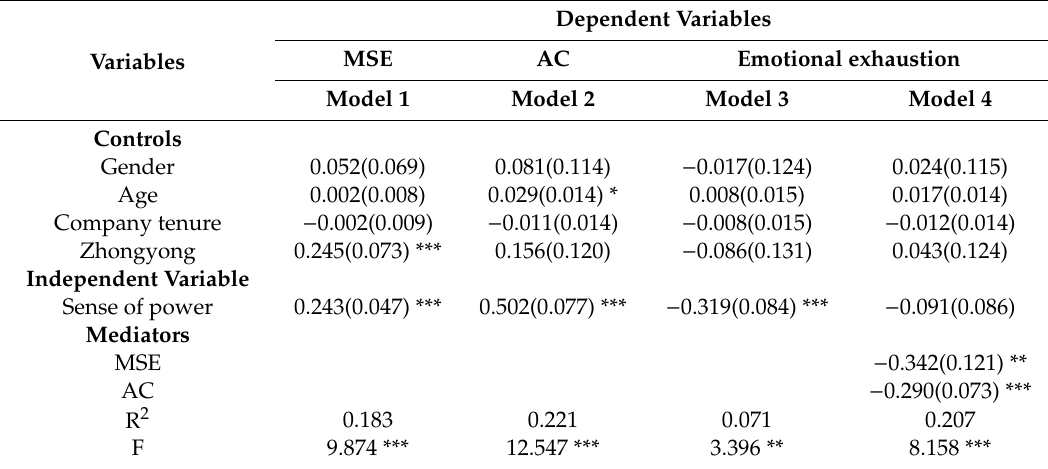
Table 3. Regression results for direct and indirect e ff ects.